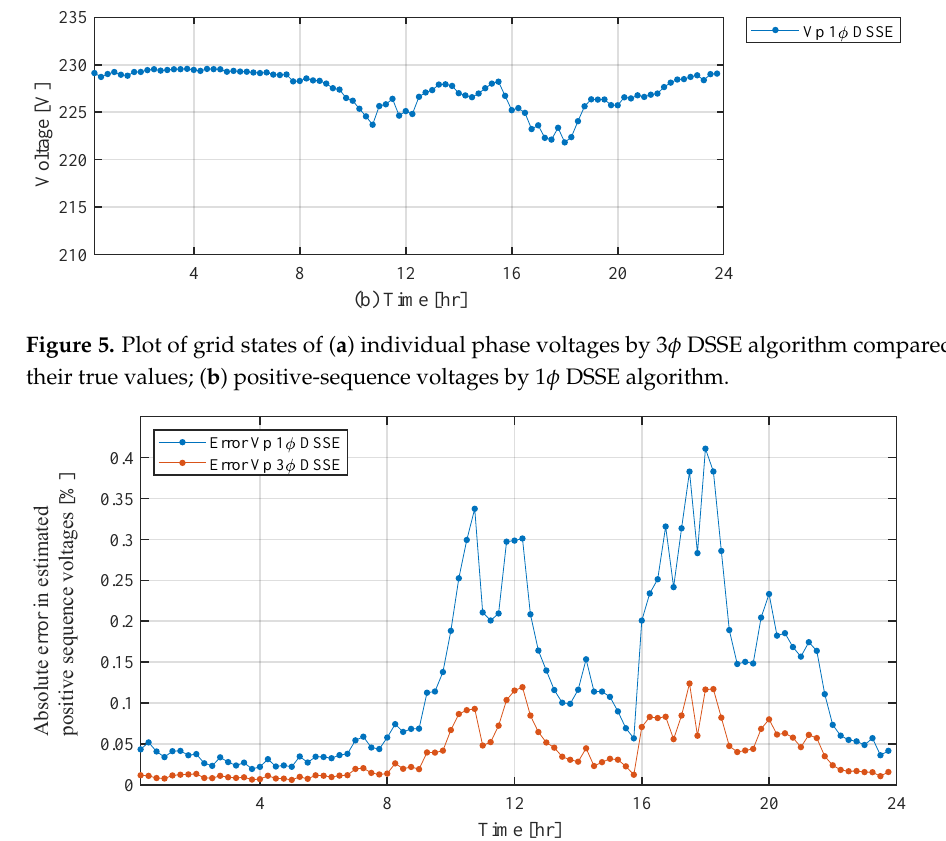
Figure 6. Estimated absolute errors in positive-sequence voltages at node